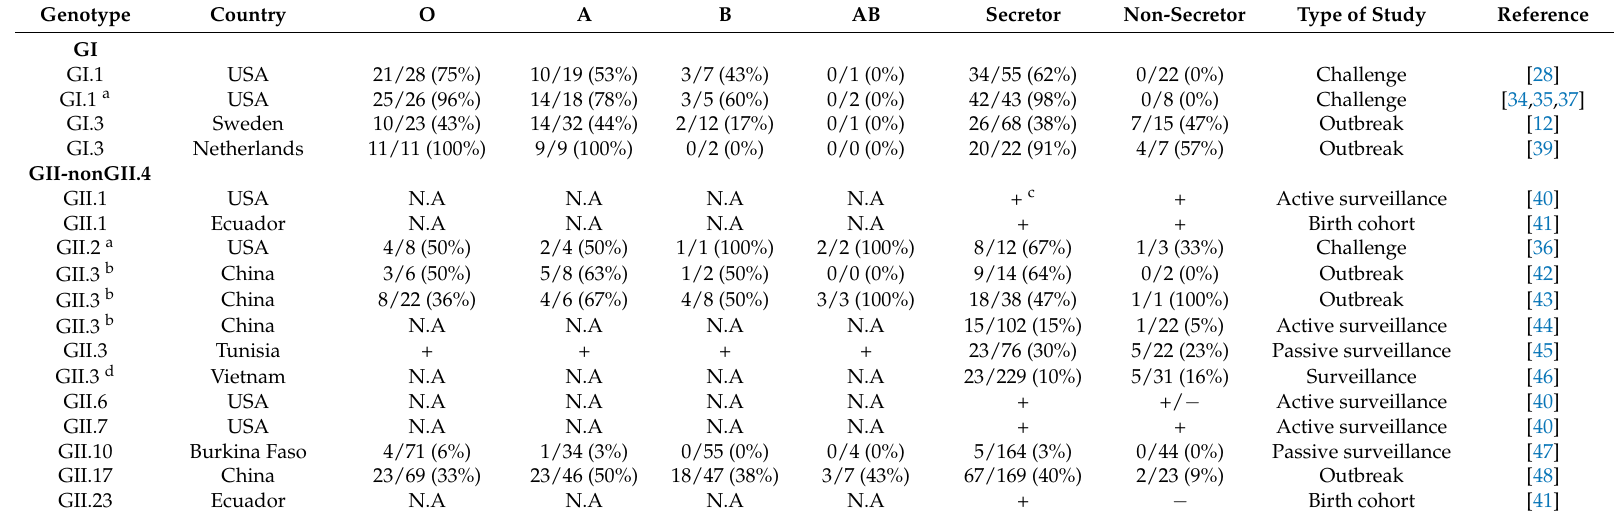
Table 2. Distribution of ABO and secretor status in studies with GI and non-GII.4 genotype infections (symptomatic and/or asymptomatic). Only included are studies and/or genotypes with at least five representative samples.